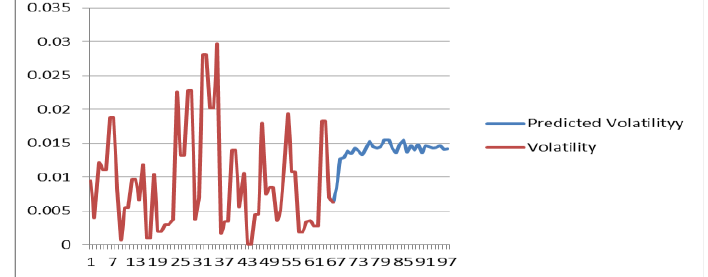
Figure.9. Long-term Prediction of NNAR based GARCH